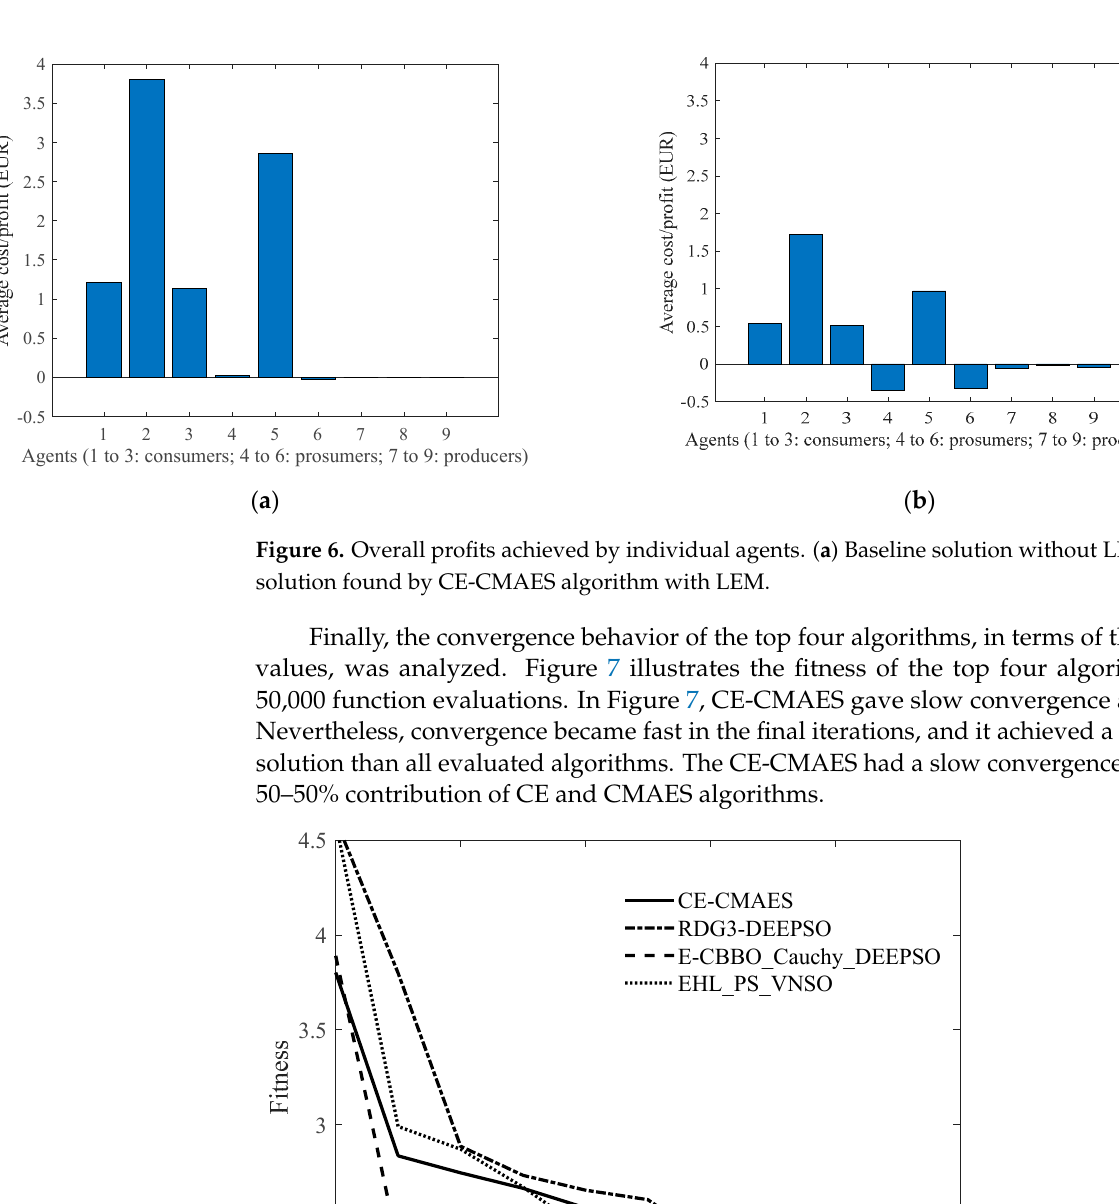
Figure 7. Convergence of fitness over number of function evaluation.